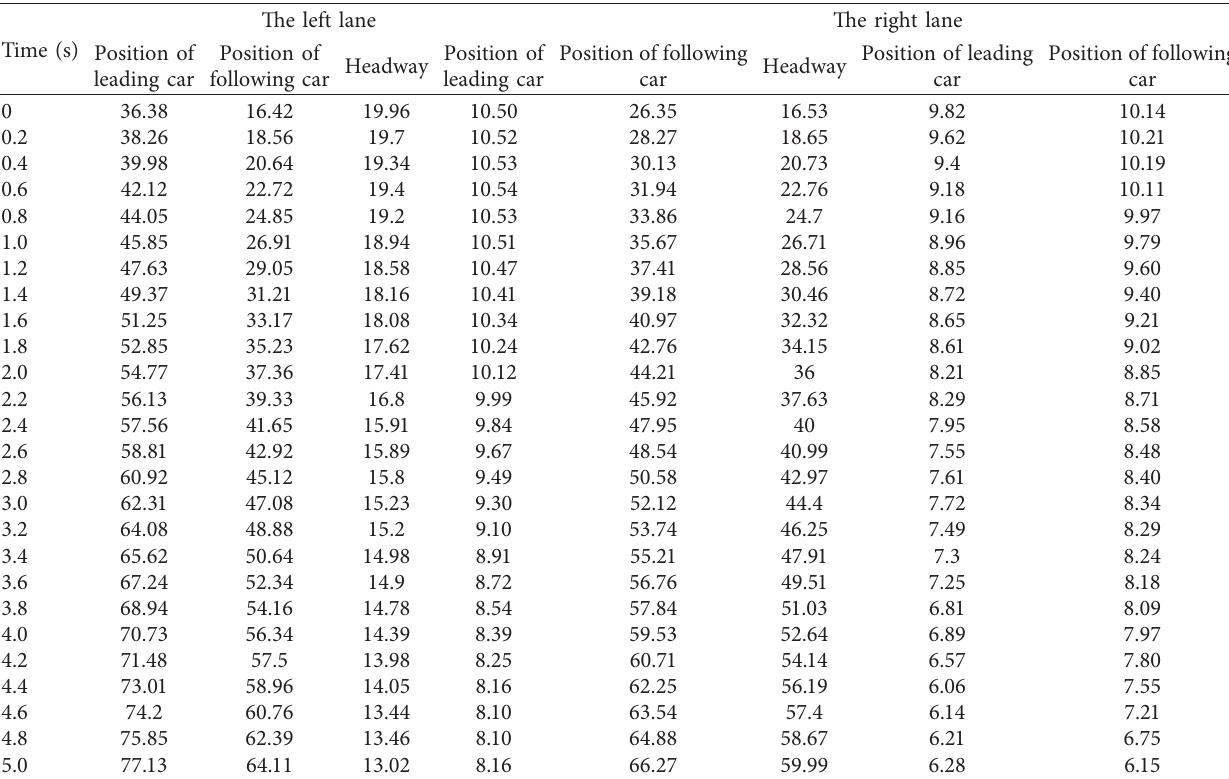
Table 5: The fourth sets of vehicle